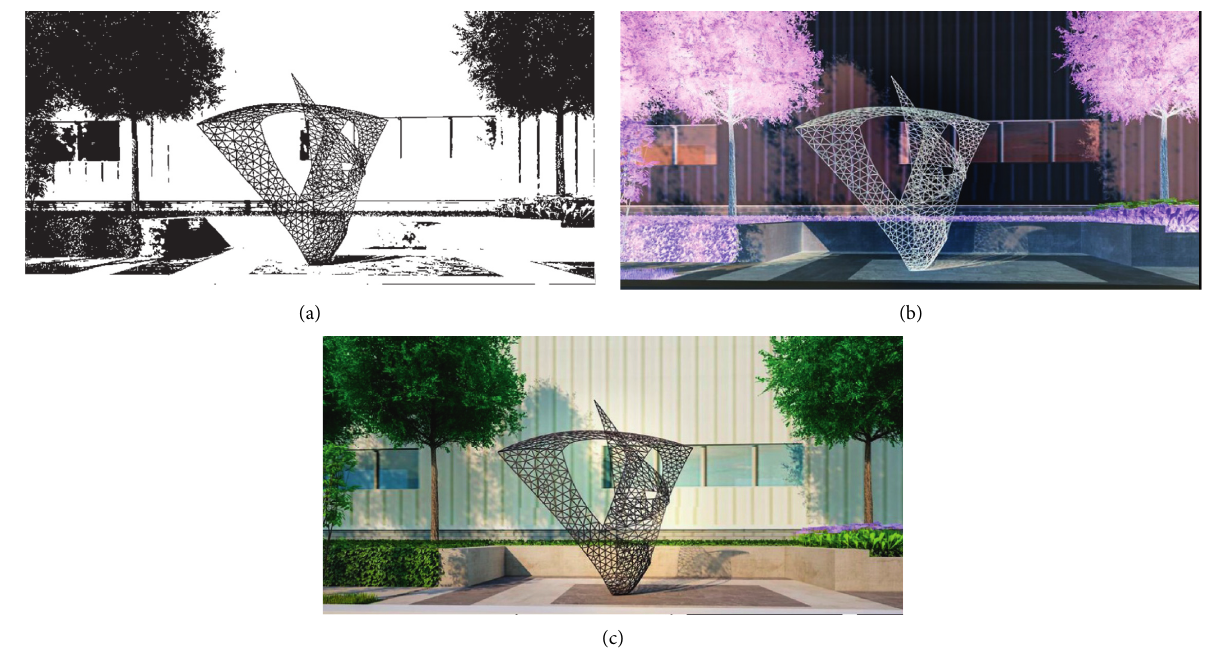
Figure 9: Cases of environmental landscape design based on artificial intelligence and digital technology. (a) Sketches of environmental landscape design based on artificial intelligence and digital technology. (b) Rendering of environmental landscape design based on artificial intelligence and digital technology. (c) The results of environmental landscape design based on artificial intelligence and digital Table 1: Digital expression effect of environmental landscape design system. Num Digital expression Num Digital expression Num Digital expression